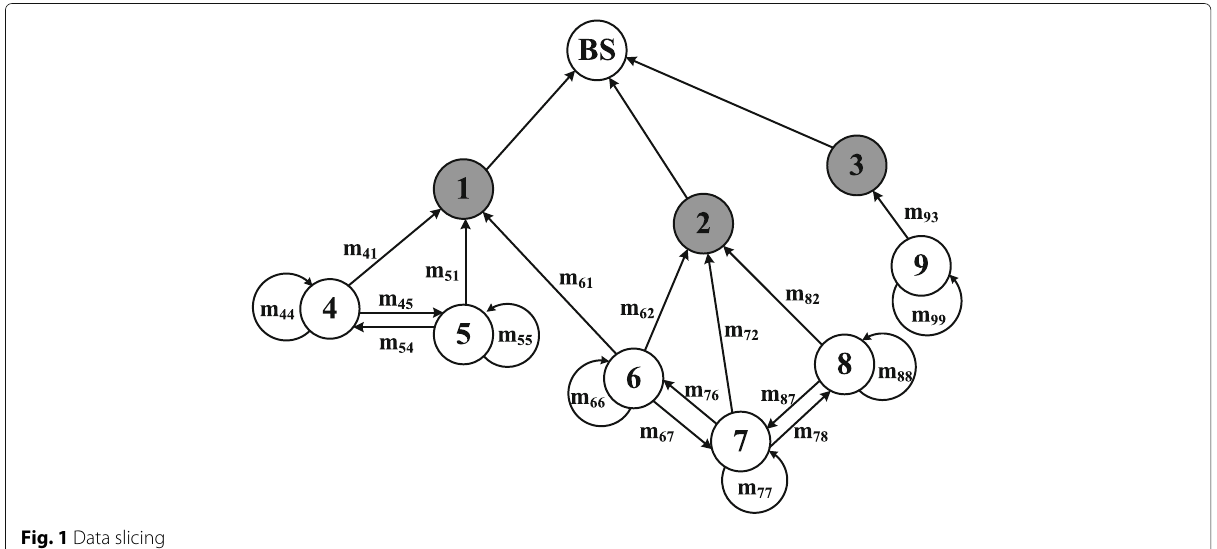
(2) The probability of collision may arise. More slices may produce more packet transmissions which may result in the higher collision probability. This is an inevitable issue in SMART. Ultimately, this may affect many network parameters, such as delay, transmission error, accuracy, and efficiency